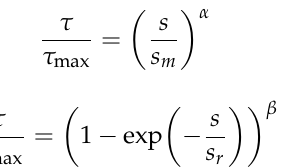
Figure 13. The ratio of average bond strength and corresponding average slip of specimens with and without stirrups ( a ) t* (Y) / t* (N); and, ( b ) s* (Y) / s*